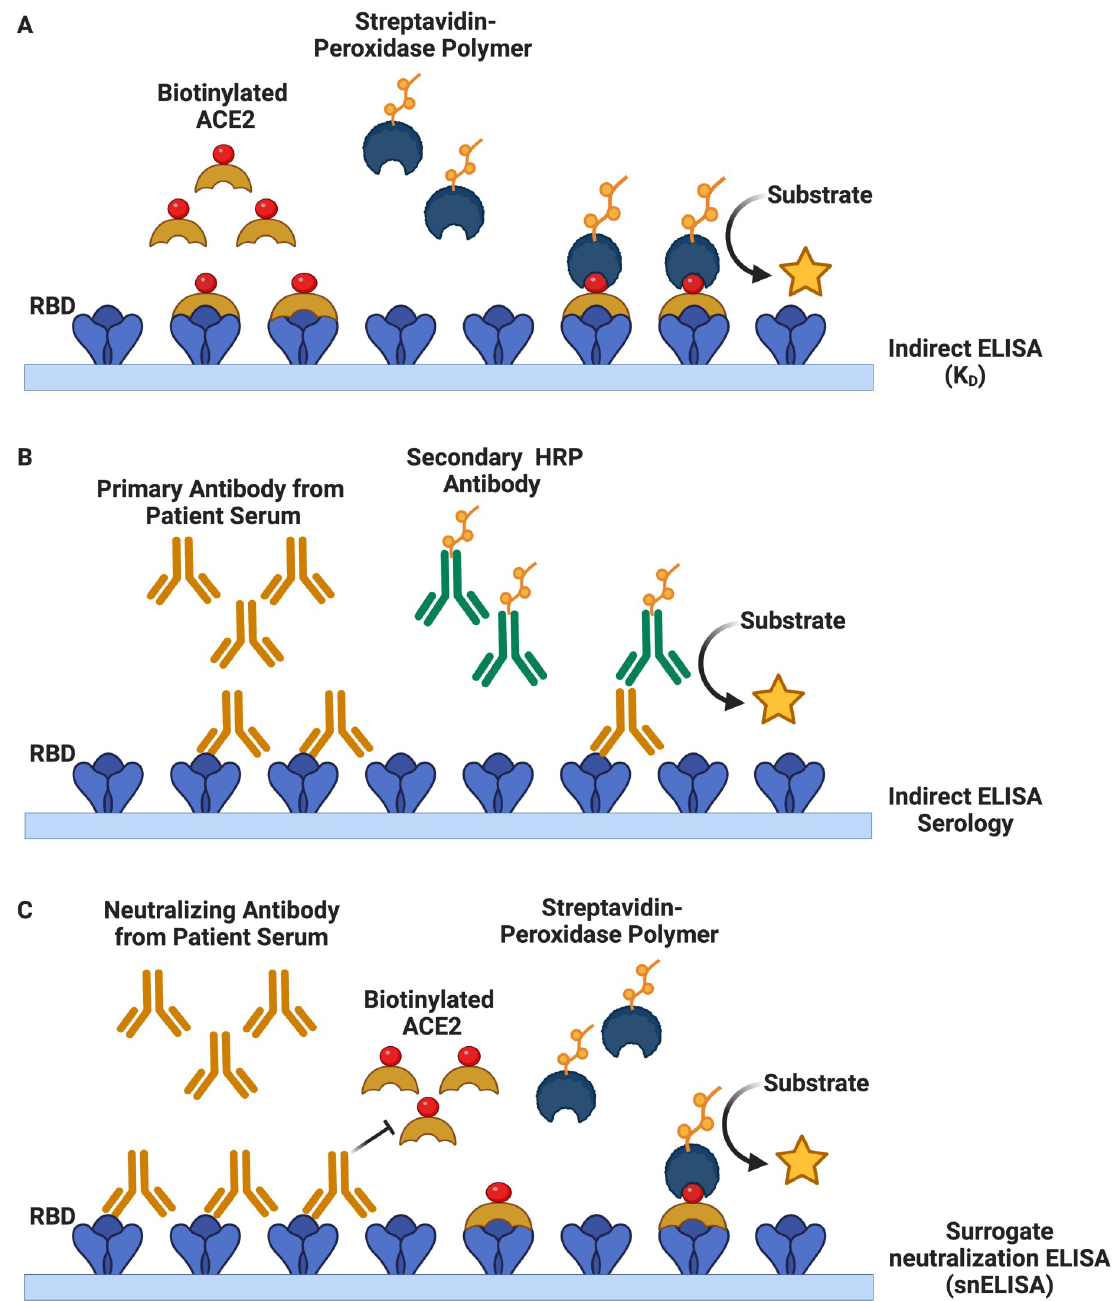
Fig 3. Schematic representations of the different types of ELISA used to characterize plant-expressed RBD. (A) Indirect ELISA (Kd) set up for the evaluation of binding kinetics of soluble human ACE2 to immobilized RBD. (B) Indirect ELISA (serology) set up for the evaluation of binding and recognition of commercial monoclonal and serum IgG, IgM and IgA antibodies to immobilized RBD. (C) Surrogate neutralization ELISA (snELISA) set up to evaluate relative inhibition of anti-SARS-CoV-2 neutralizing antibodies in blocking immobilized RBD from binding soluble